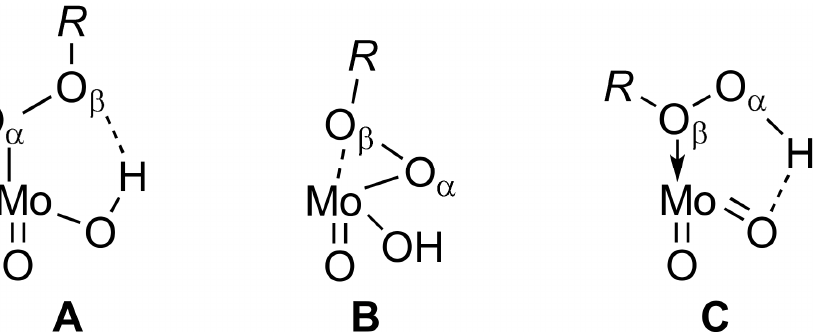
Figure 9. Structures of active oxidizing intermediate species reported in the literature for liquid phase catalytic reactions of olefins, in the presence of molybdenum coordination compounds and using hydroperoxide oxidants (R = alkyl or H). The structures differ regarding the absence ( A ) or presence ( B , C ) of an interaction between O β and the metal